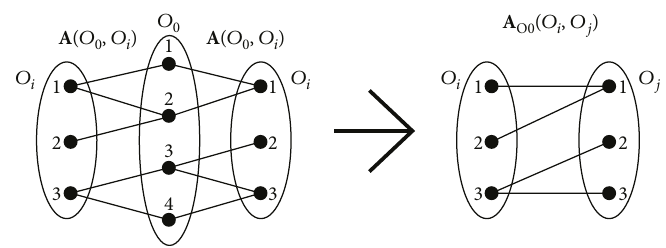
Figure 3: Projection of a property connection.